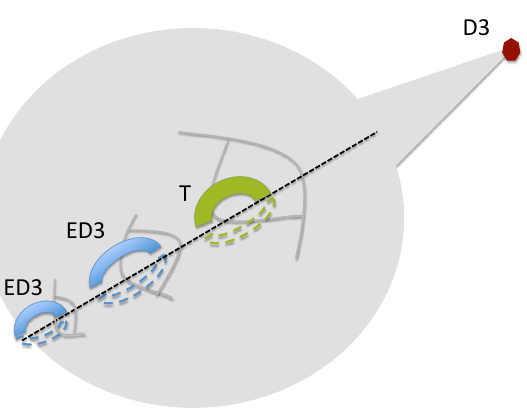
Figure 2 . Global embedding of an orientifolded quiver. The action of the orientifold involution is represented by the dashed line. The two del Pezzo divisors in the geometric regime support ED3-instantons while the large four-cycle is wrapped by a hidden D7 stack (T-brane) which is responsible for a dS vacuum. Both the ED3-instantons and the D7 T-brane wrap invariant divisors.